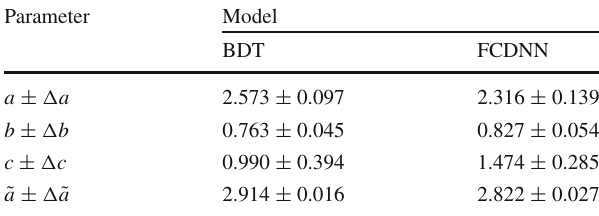
Fig. 14 Energy resolution performance: resolution (upper panel) and bias (lower panel) for BDT and FCDNN models. Note that the most left point corresponds to 1.122 MeV Table 3 Parameters a , b , and c of parameterization for the energy res- olution curves and effective resolution ˜ a for BDT and FCDNN